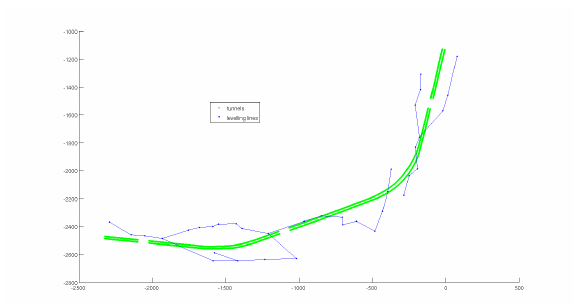
Figure 4. The location of the vertical control lines with respect to the tunnels (note that the interruptions of the tunnels referring to the presence of a stations). The axes are in meter, re- ferring to coordinates in the Budapest Municipal Projection